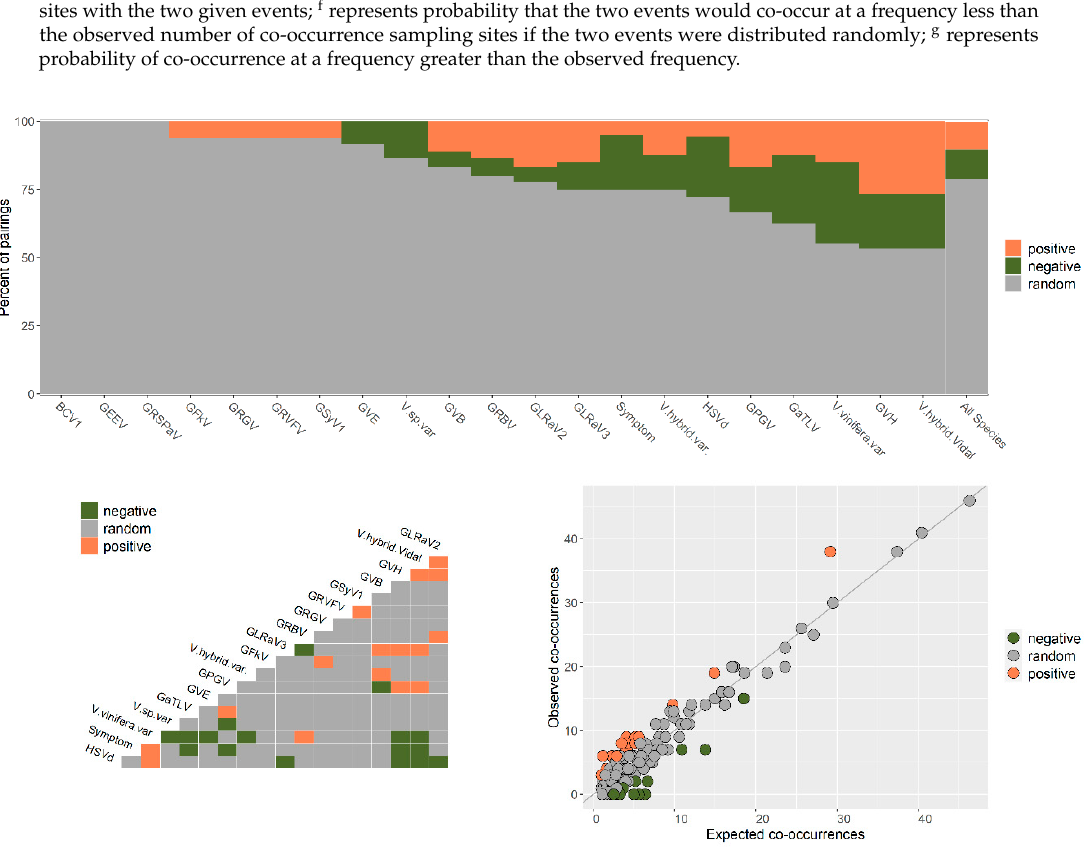
Figure 6. The percent of total pairings for virus species, leafroll-like symptoms and grapevine cultivars that are positive, negative and random (boxplot top graph). The bar outline in white shows the assemblage-wide percentages. A heatmap of the positive, negative and random associations (bottom-left graph) displays the probabilistic co-occurrence that observed frequency of co-occurrence between two events (e.g., virus, viroids or symptoms presence in a given sample) is significantly greater (large) than expected (meaning a positive association), significantly less (small) than expected (meaning negative association), or not significantly different and approximately equal to expectation (meaning random association)). Events are positioned to indicate the columns and the rows that represent their pairwise relationships. Graphic displaying the scatter plot of observed versus expected co-occurrence (bottom-right graph). Each event pair in the analysis is represented by a circle colored based on whether it was classified as positive (orange), negative (dark green) or random (gray). Any event pairs that were expected to share less than one sampling unit were removed from the analysis. R package co-occur was used (see materials and methods section for more details). See Table 1 for virus names and abbreviations.